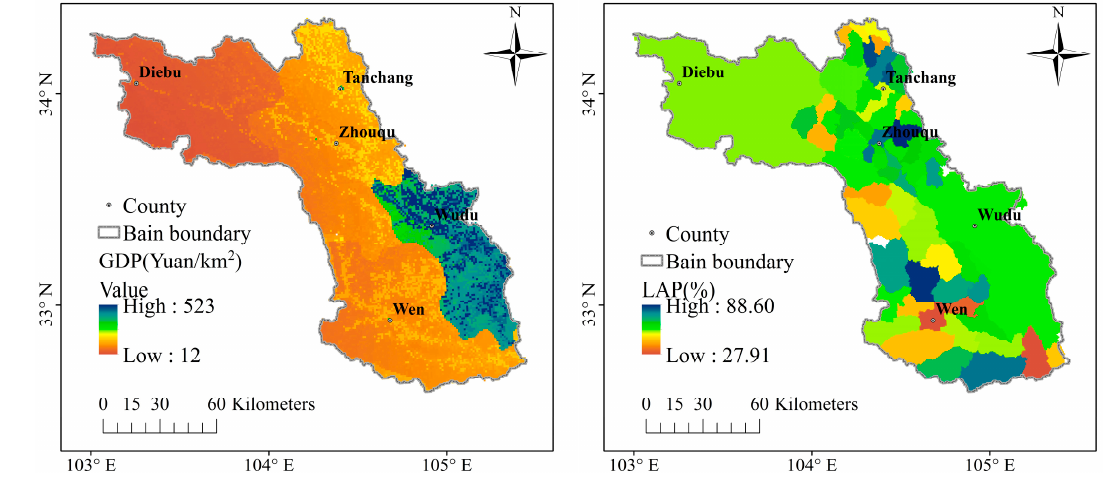
Figure 9. Spatial distribution of factors characterising resilience.